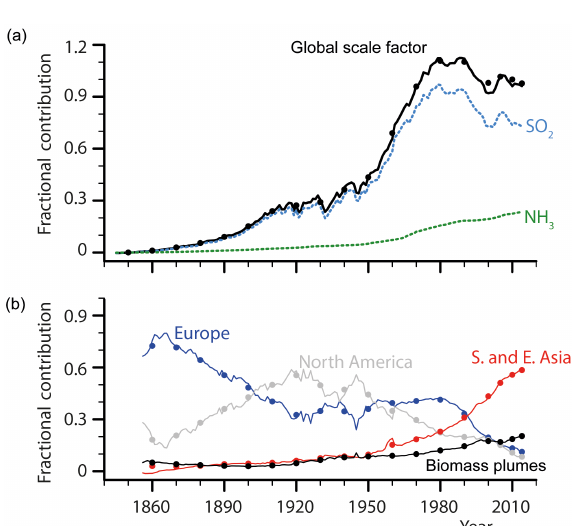
Figure 9. Contributions to anthropogenic AOD distribution. The annual scaling factor for the global emissions, E(t y ) shows the strength of the globally averaged post-1850 anthropogenic AOD rel- ative to its value in 2005, along with the relative weighting of its pre- cursors which scale with SO 2 versus NH 3 emissions, respectively, panel (a) . Contributions (panel b ) from the E i (t y ) by different re- gions to E(t y ). Contributions (panel b ) from four regions: Europe (blue), North America (grey), south and east Asia (red) and the four biomass plumes (black). The 11-year averages centered on the mid- dle year of a decadal average are shown by filled circles. The depar- ture between the circles and the lines for the Asian plumes in 1850 is because emissions over east Asia are estimated to have decreased in the first decade after 1850, and the decadal scaling coefficients were not allowed to be negative.